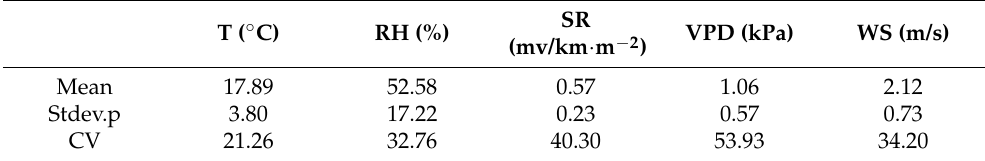
Table 2. Meteorological indicators during the sampling